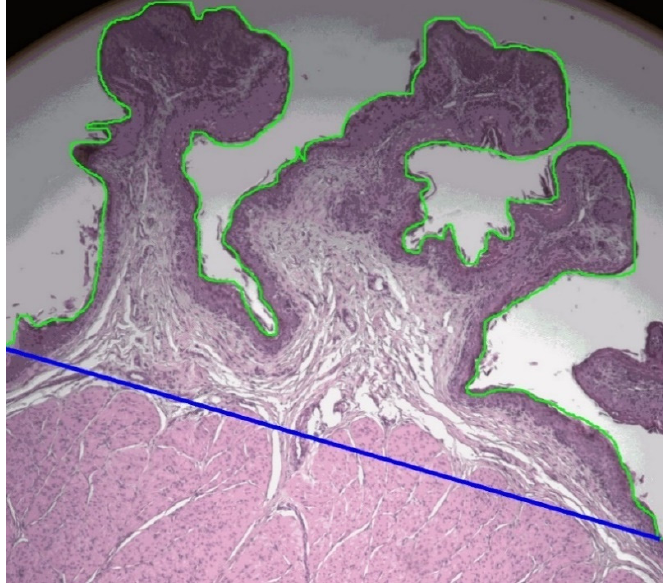
Figure 2. The length of papillae outer boundary of the stratum corneum (green line) and the respective straight length of rumen tissue (blue line) measured in dorsal and ventral sites of rumen by FIJI ImageJ software, to calculate the ratio between length of papillae surface/straight length of rumen tissue (PSL/STL) of lambs.